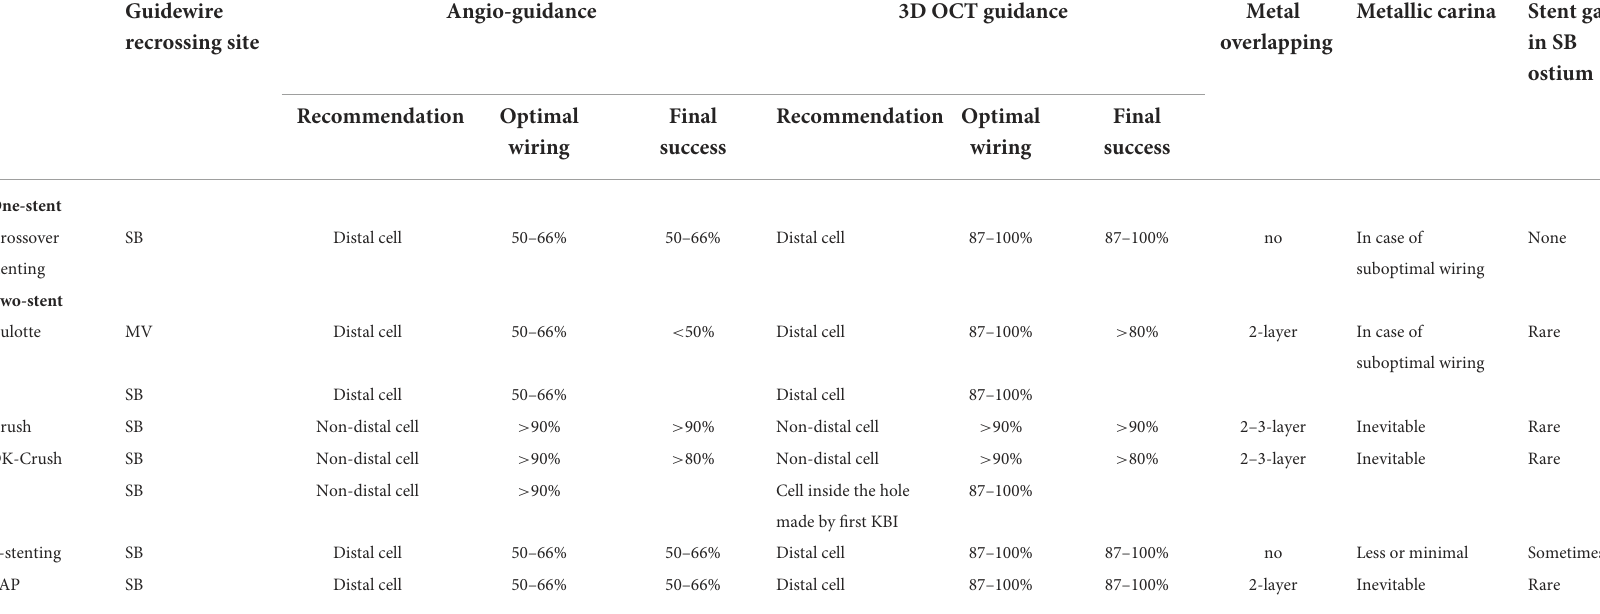
TABLE 1 Impact of angio-guidance and three-dimensional optical coherence tomography (3D OCT) guidance on optimal guidewire recrossing and other stent failure in coronary bifurcation